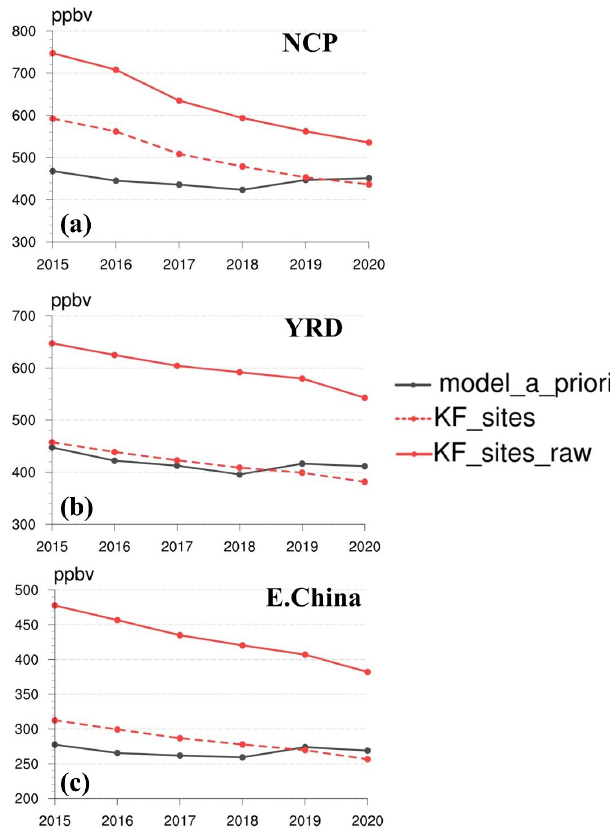
Figure 6. Surface CO concentrations in 2015–2020 from a pri- ori simulations (black line), Kalman filter, by assimilating raw (red solid line) and normalized (red dashed line) MEE CO.